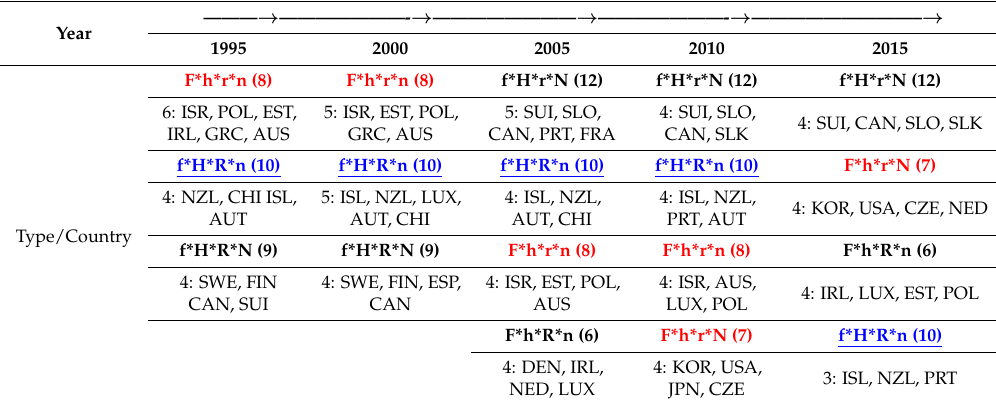
Table 7. Trend of the most ideal types results from Y1995 to